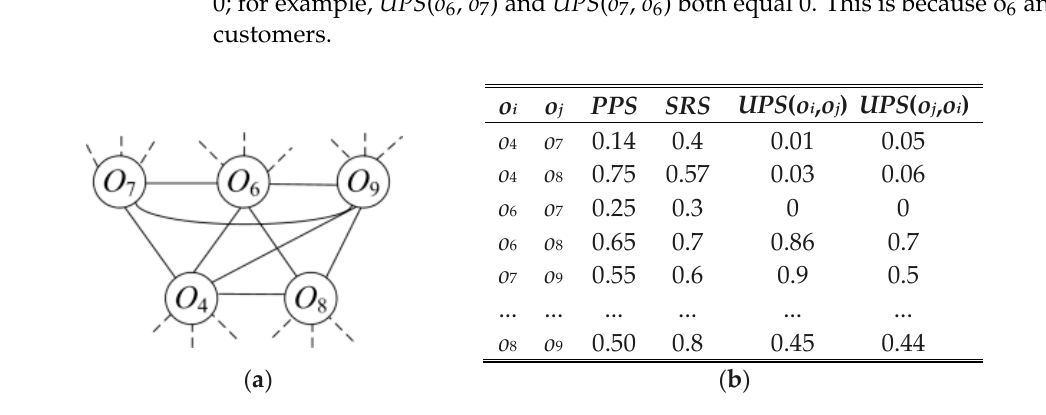
Figure 5. Example of POI graph: (a) Visual structure of POI graph; (b) Content of POI graph. Category Graph: The structure of a category graph is similar to that of a POI graph, as shown in Figure 6. Nodes are shown as categories, while edges represent the correlation scores between categories.